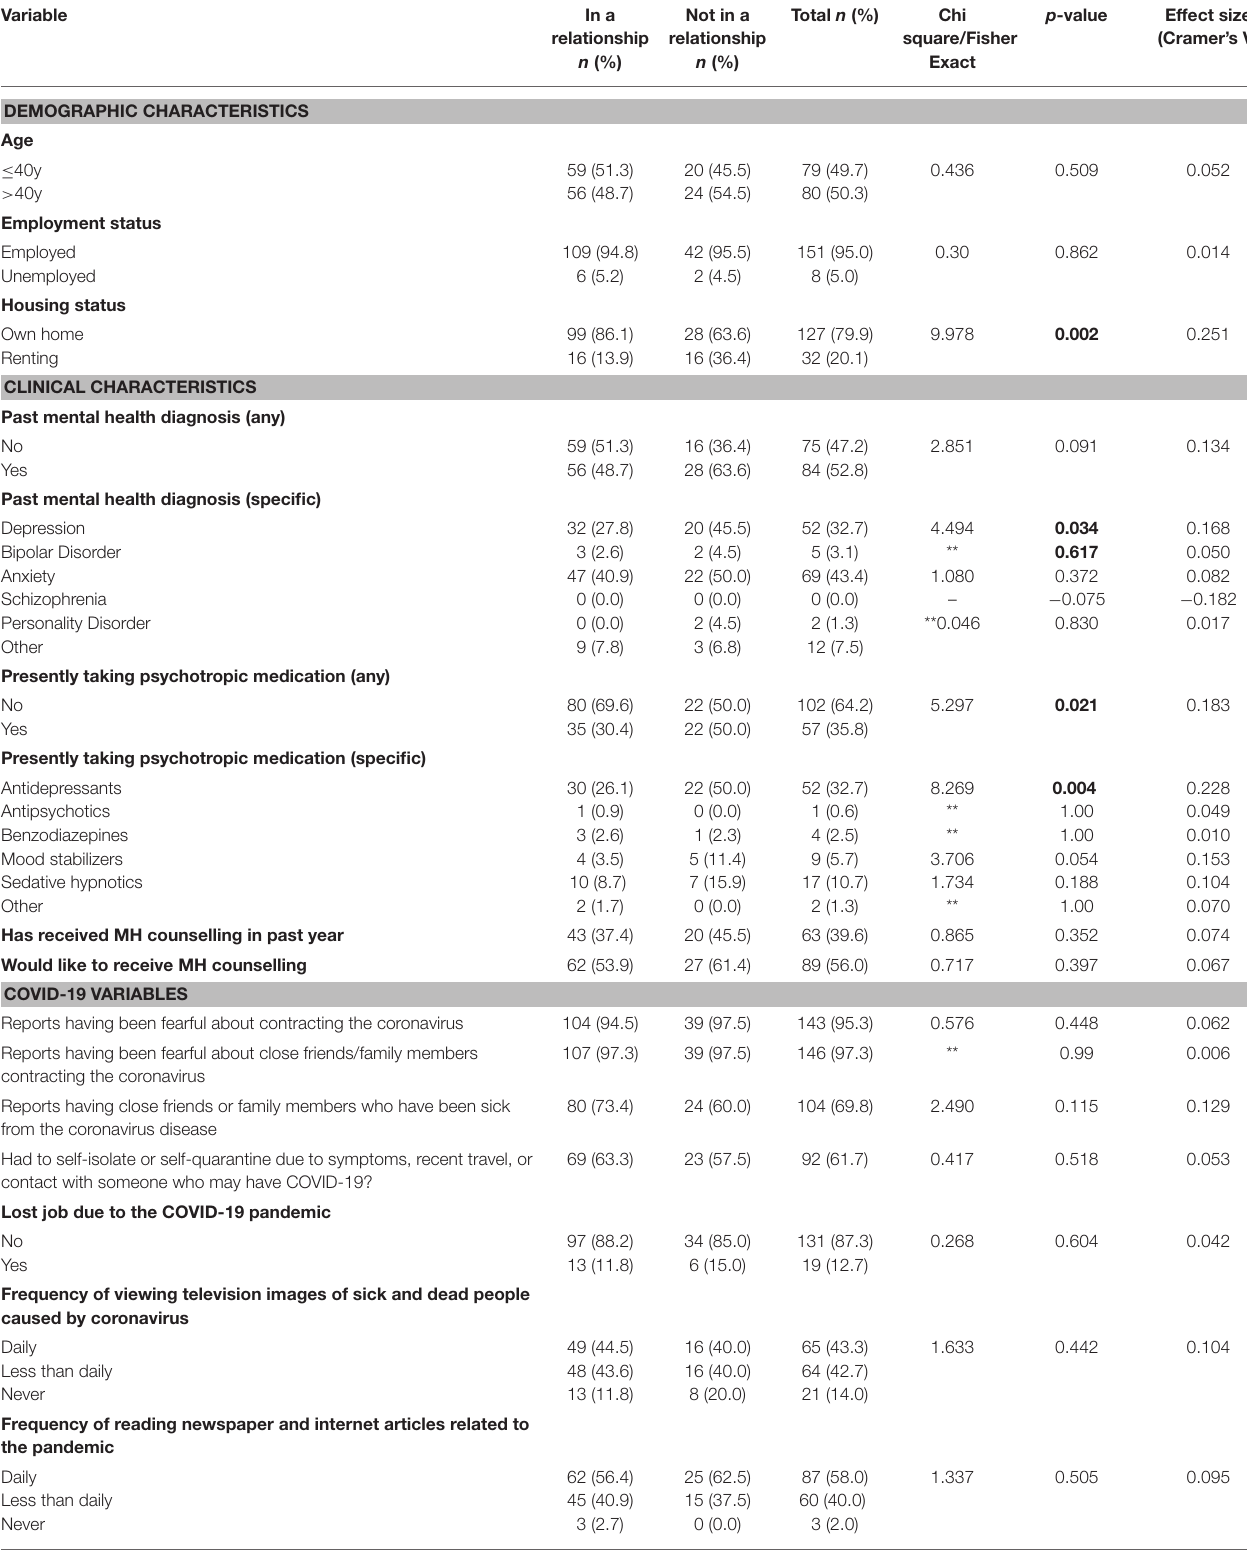
TABLE 1 | Demographic profile, clinical characteristics, and responses to COVID-19 of female respondents in Fort McMurray, as a function of relationship